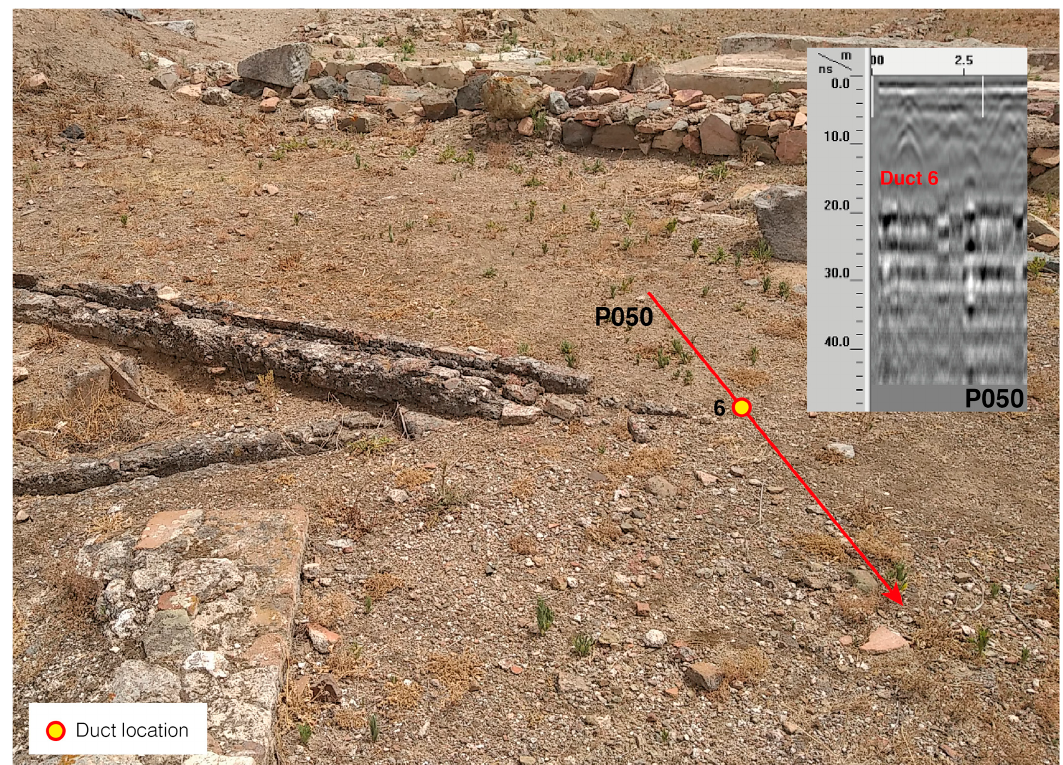
Remote Sens. 2023 , 15 , x FOR PEER REVIEW Figure 7. Representation of the B-scan P050 and location in the field. Figure 7. Representation of the B-scan P050 and location in the field.